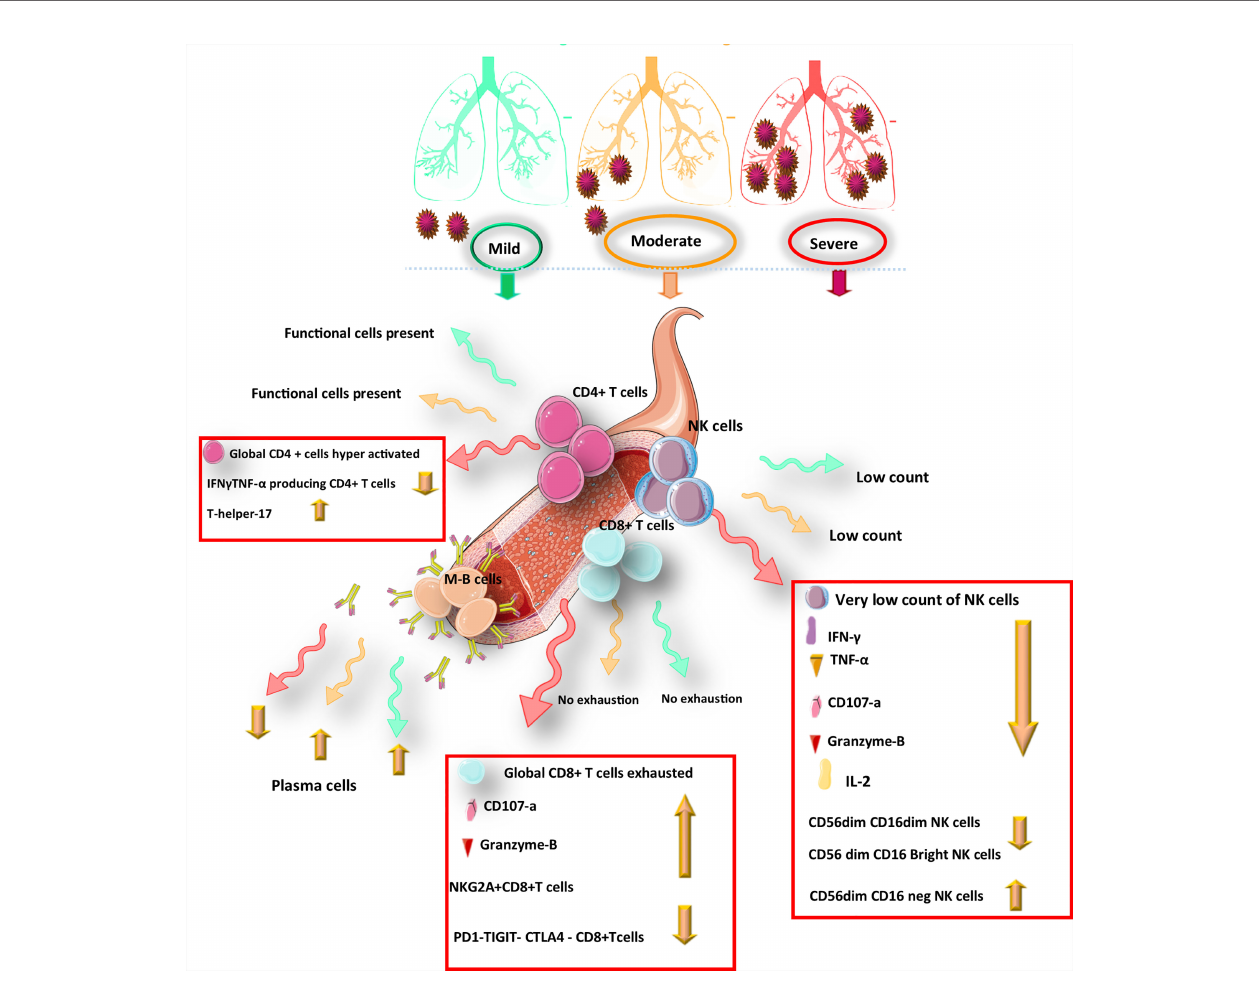
FIGURE 1 | Schematic representation of the protective immunity against COVID-19 infection during